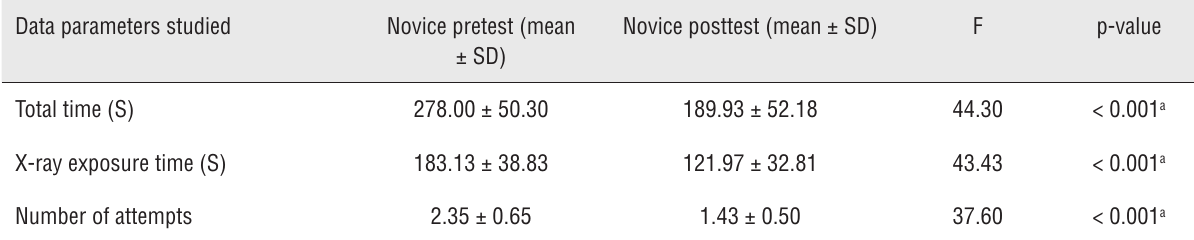
Table 3 - Acquisition of skills